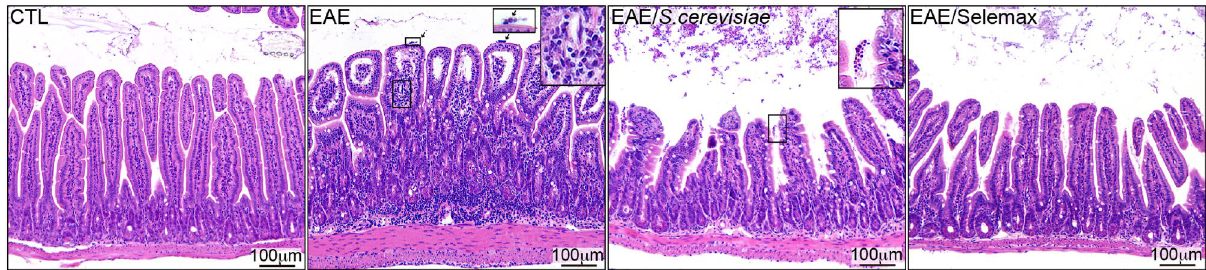
Figure 7. Effect of S. cerevisiae and Selemax on small intestine inflammation. EAE mice received 14 oral doses of S. cerevisiae or Selemax. The inflammatory infiltrate of the lamina propria of the small intestine was evaluated using hematoxylin/eosin stained sections of control – CTL (non-EAE and non-supplemented mice), EAE, EAE/ S. cerevisiae and EAE/Selemax groups. One independent experiment, n = 4–5 mice/group. Image was created with Adobe Photoshop